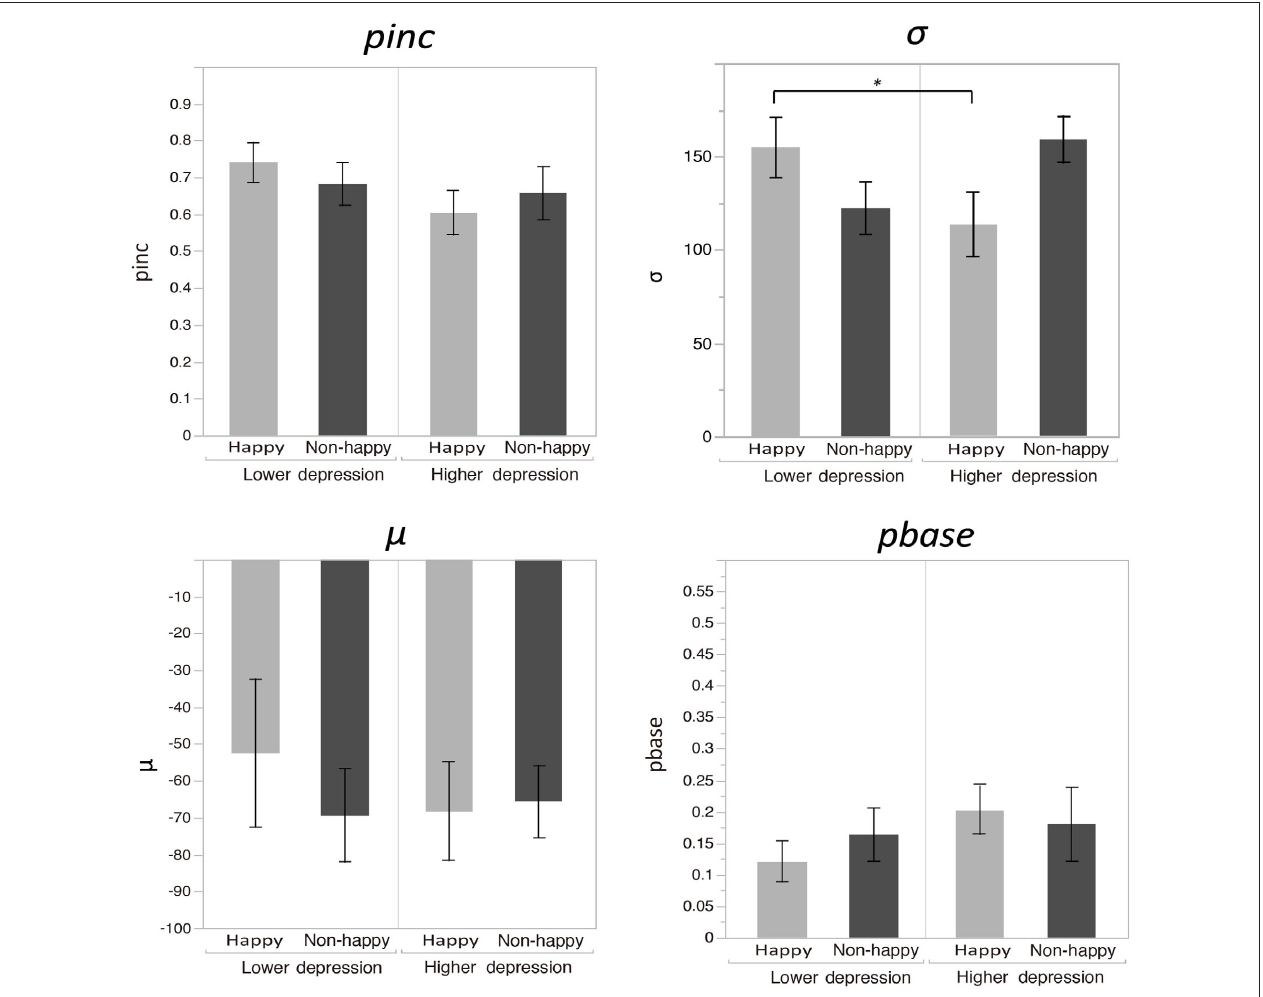
FIGURE 3 | Mean values of each parameter ( σ , µ , pinc and pbase ) that were derived from the Gaussian fitting for the happy and non-happy conditions in the two depression groups . Error bars show the standard errors of the means.